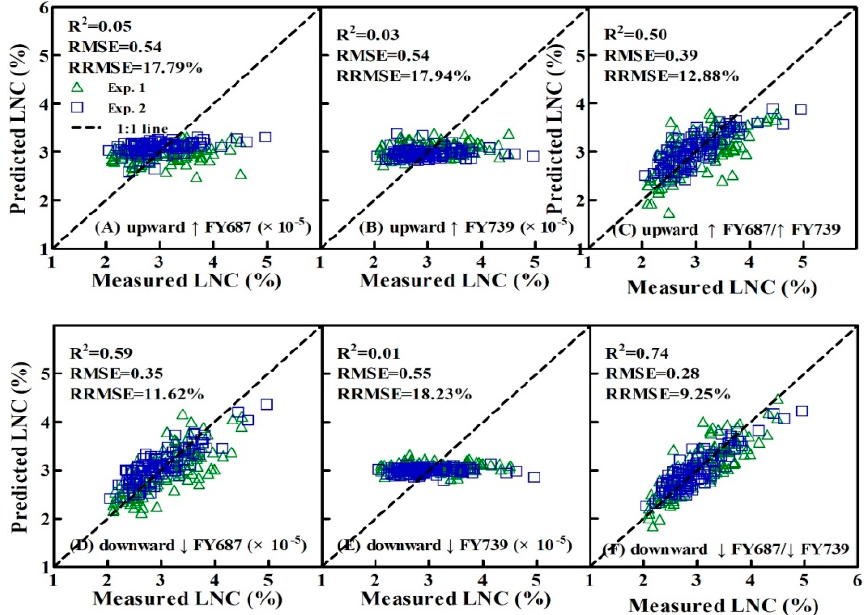
Figure 7. Comparisons between measured and predicted LNC. ( A ) the upward ↑ FY687 (×10 − 5 ); ( B ) the upward ↑ FY739 (×10 − 5 ); ( C ) the upward ↑ FY687/ ↑ FY739; ( D ) the downward ↓ FY687 (×10 − 5 ); ( E ) the downward ↓ FY739 (×10 − 5 ); ( F ) the downward ↓ FY687/ ↓ FY739. Data points from the Experiment 1 and Experiment 2 data sets are shown in green (triangle) and blue (square), respectively.